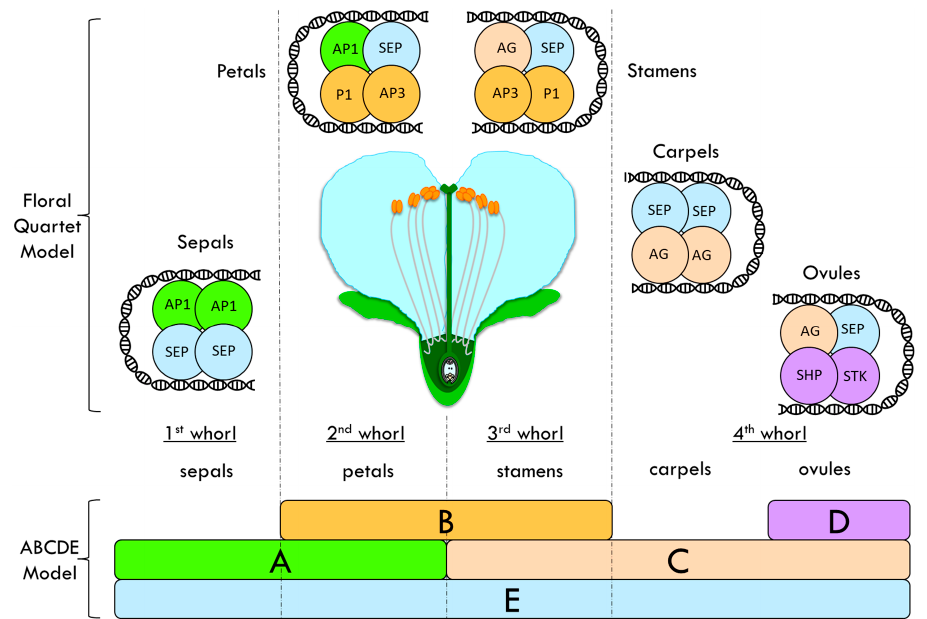
Figure 2. Floral quartet model (FQM) integrated into the ABCDE model proposed to explain the flower whorls’ identity determination in Arabidopsis thaliana . This enhanced ABCDE model postulates that sepals are specified by A + E, petals by A + B + E, stamens by B + C + E, carpels by C + E and ovules by C + D + E. Class-A protein: APETALA1 (AP1); Class-B proteins: PISTILLATA (PI) and APETALA3 (AP3); Class-C protein: AGAMOUS (AG); Class-D proteins: SEEDSTICK (STK) and SHATTERPROOF (SHP); Class-E protein: SEPALLATA